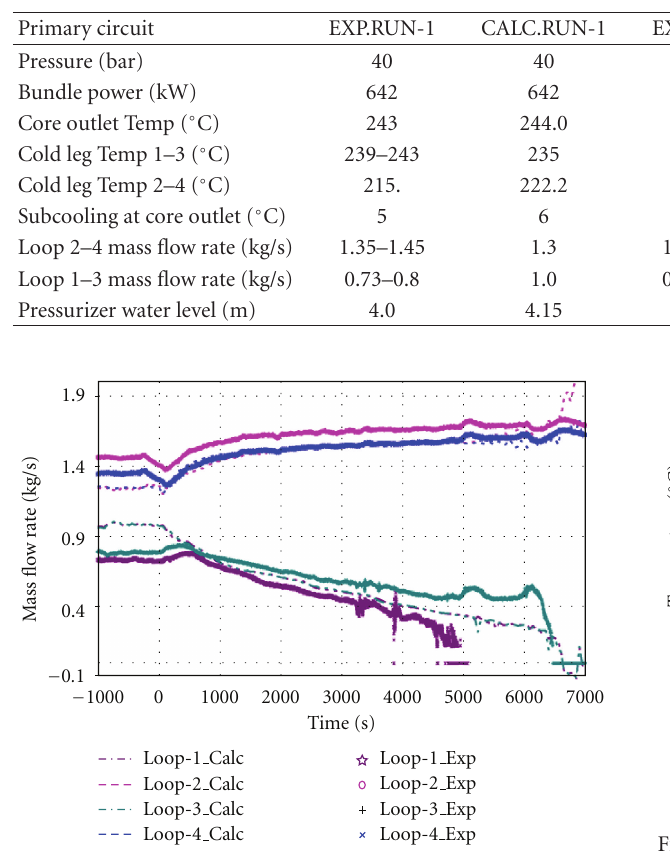
Figure 6: Run-1: Loops flow rate evolutions.